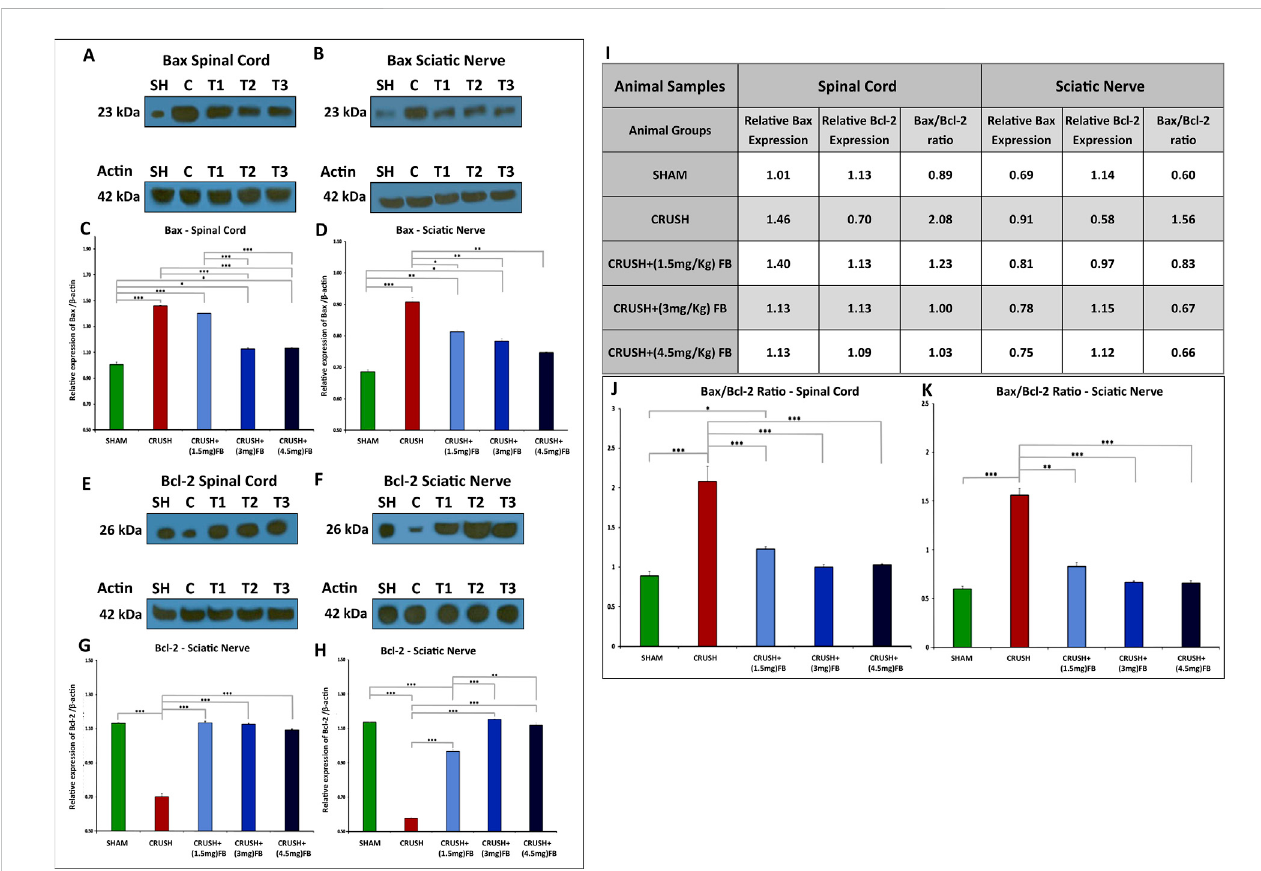
FIGURE 12 (A – D): FB inhibits neuronal apoptosis after sciatic nerve crush injury. The expression levels of Bax in the spinal cord neurons (A and C) and sciatic nerve (B and D) were detected using Western blot analysis at week 4 after sciatic nerve crush injury. (C, D) Quantitative analysis of Western blotting shows increased Bax expression levels in the CRUSH group after injury. However, Bax expression levels were signi fi cantly decreased in FB treatment groups comparedto theCRUSHgroup.Dataareexpressedasmean±SEM.* p < 0.05,** p < 0.01,and*** p < 0.001. (E – H): FBinhibitsneuronalapoptosisafter sciatic nerve crush injury. The expression levels of Bcl-2 in the spinal cord neurons (E and G) and sciatic nerve (F and H) were detected using Western blot analysis at week 4 after sciatic nerve crush injury. (G, H) Quantitative analysis of Western blotting shows decreased Bcl-2 expression levels in the CRUSH group after injury. However, Bcl-2 expression levels were signi fi cantly increased in FB treatment groups compared to the CRUSH group. Data are expressed as mean ± SEM. * p < 0.05, ** p < 0.01, and *** p < 0.001. (I – K): The Bax/Bcl-2 ratio in the spinal cord neurons and sciatic nerve was detected usingWesternblotanalysisatweek4aftersciaticnervecrushinjury. (I) ComparisonofBax/Bcl-2ratioonspinalcordandsciaticnervecrushinjuryafterFB treatment. (J,K) Quantitative analysis shows decreased Bax/Bcl-2 ratio in spinal cord and sciatic nerve in all FB-treated groups compared to the CRUSH group after injury. Data are expressed as mean ± SEM. * p < 0.05, ** p < 0.01, and *** p <